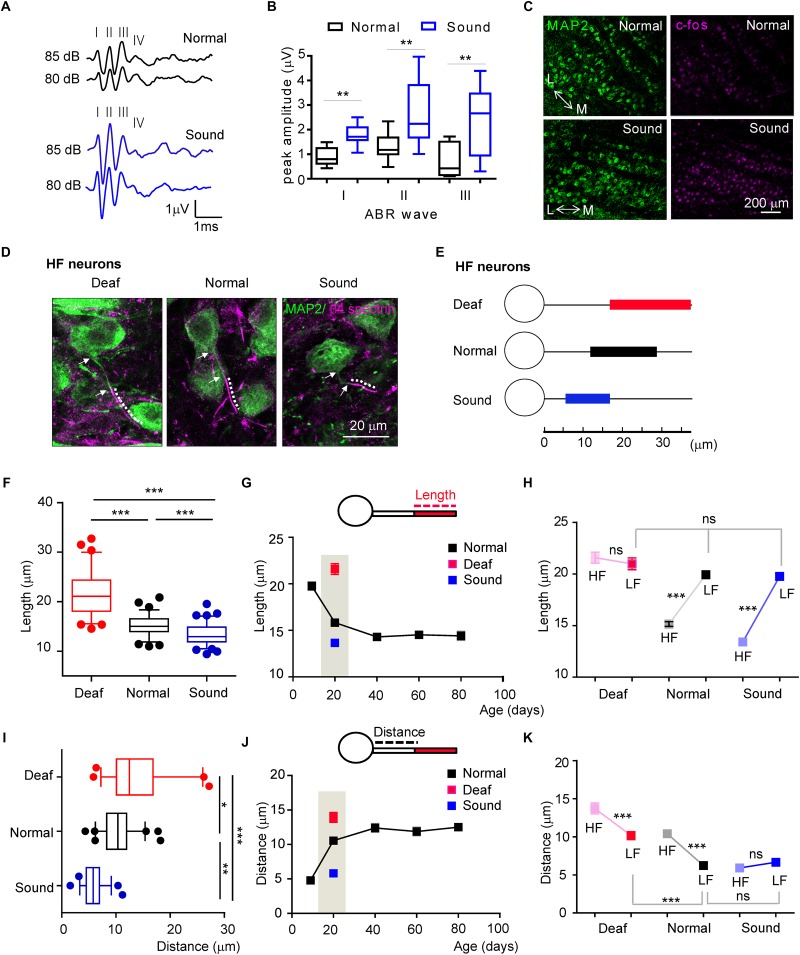
Sound deprivation and stimulation impact developmental refinement of AIS structure, position, and tonotopy in the MNTB. (A) Examples of the ABRs of normal (black) and sound stimulated mice (blue) are recorded in response to a click stimulus of sound (80 and 85 dB). Roman numerals indicate peak waves I to IV (B) Summary of the amplitude of waves I to III in response to click stimulus (85 dB) in normal and sound stimulated mice at P20. ∗∗p < 0.01, unpaired t-test. (C) Immunostaining of the MNTB with c-fos and MAP2 from normal and sound stimulated mouse with the tonotopic axis (M: medial MNTB, L: lateral MNTB). Note, the number of c-fos positive cells is increased in the MNTB of the sound stimulation group. (D) HF neurons, immunostained with MAP2 and β4 spectrin from deaf mice (Deaf), age-matched normal hearing mice (Normal), and sound stimulation group (Sound). The dotted line and white arrow indicate AIS length and distance, respectively. (E) Diagram of AIS length and location in HF neurons from Deaf (red), Normal (black), and Sound (blue). (F) Summary of AIS length in HF neurons from Deaf, Normal, and Sound at P20. ∗∗∗p < 0.0001, one-way ANOVA with Turkey’s multiple comparison test. (G) The plot of AIS length of HF neurons from normal mice from P9 to P80 (black, as shown in Figure 3D), and those from Deaf and Sound at P20. (H) Tonotopic differentiation of AIS length between HF and LF neurons in Deaf, Normal, and Sound. ∗∗∗p < 0.0001, Mann–Whitney U test for HF and LF neurons; ns, non-significant, Kruskal–Wallis with Dunn’s post hoc test for AIS length of LF neurons from Deaf, Normal, and Sound. (I) Summary of AIS location, as defined by the distance from the soma, of HF neurons in Deaf, Normal, and Sound at P20. ∗∗∗p < 0.001, Kruskal–Wallis with Dunn’s post hoc test. (J) The plot of AIS location changes during postnatal development in normal mice from P9 to P80 (black, as shown in Figure 3E), and those in Deaf and Sound at P20. (K) Tonotopic differentiation of AIS location between HF and LF neurons in Deaf, Normal, and Sound at P20. ∗∗∗p < 0.0001, either Mann–Whitney U test or unpaired t-test for HF and LF neurons, Kruskal–Wallis test with Dunn’s post hoc test for AIS distance of LF neurons from Deaf, Normal, and Sound.